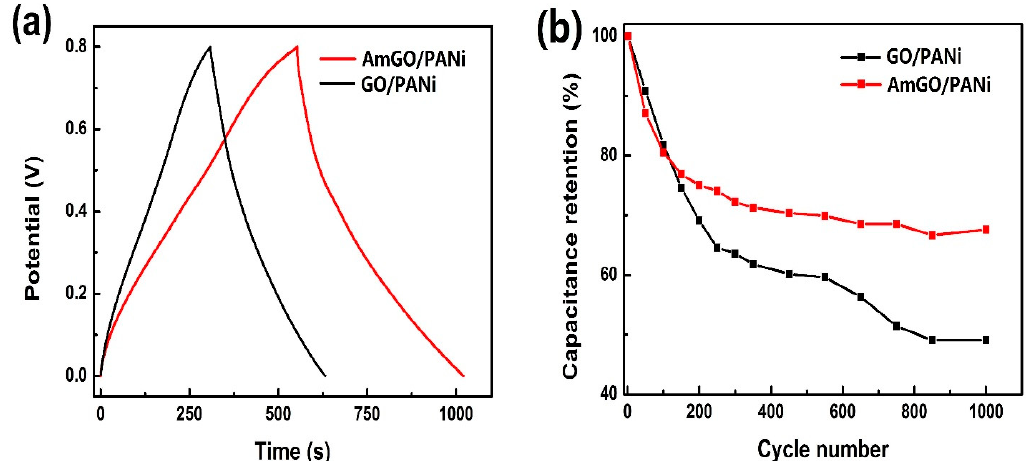
Figure 9. ( a ) charge-discharge curves of AmGO/PANi and GO/PANi at a current density of 1 A · g − 1 and ( b ) cycling stability of AmGO/PANi and GO/PANi at a current density of 2 A · g − 1 .